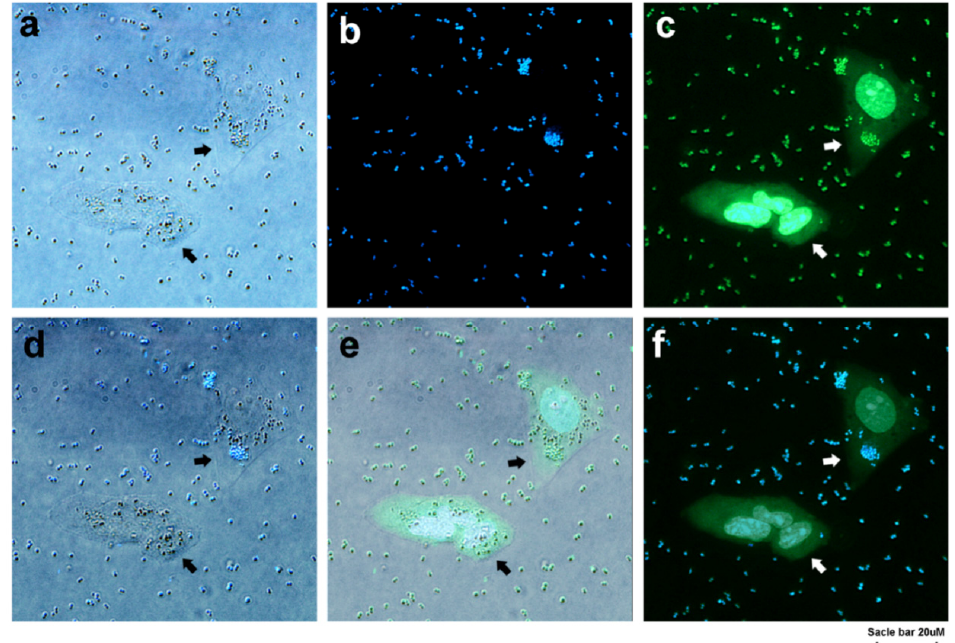
Figure 4. The microscopic images. ( a ) VRSA in presence of PNT1A cells; ( b ) VRSA in presence of PNT1A cells stained with TGQDs and imaged under UV filter; ( c ) VRSA mixed with PNT1A cells stained with SYTO9 and imaged under fluorescence microscope through 485/498 filter; ( d ) Merged image of (a) and (b); ( e ) Merged image of (a) and (c); ( f ) Merged image of (b) and (c).